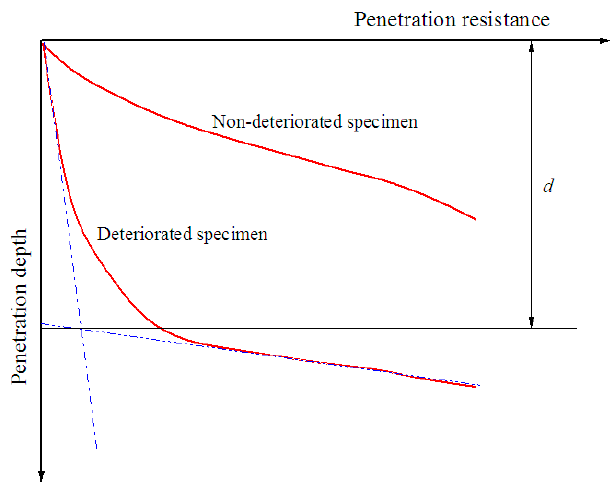
Figure 4. Penetration resistance-depth curves.